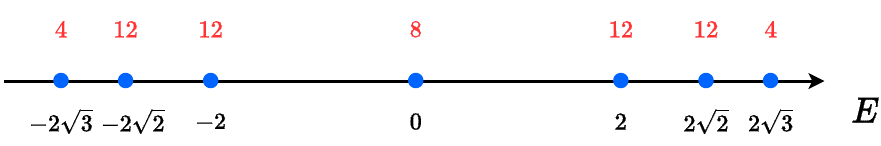
Figure 2: The energy spectrum of the homogeneous Fendley model (31) with system size L = 6. The red numbers above are the degeneracies of the different energy